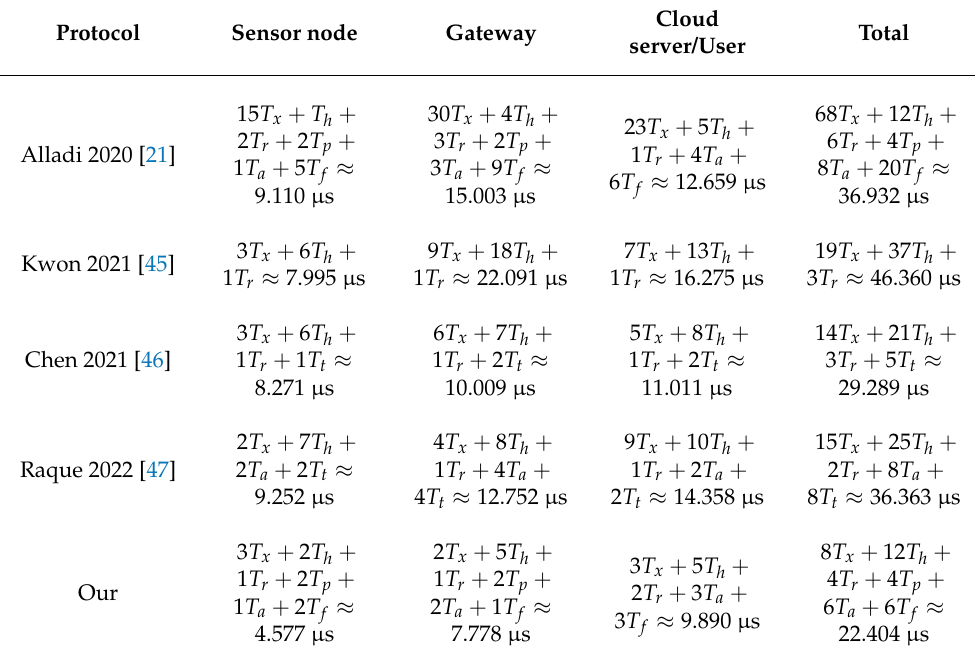
Table 5. The number of